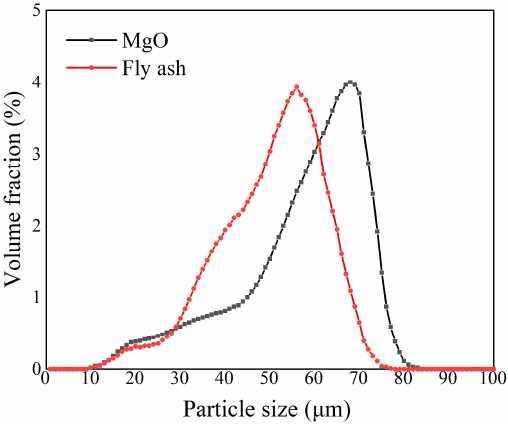
Figure 1. Particle size distribution of calcined magnesia and fly ash.